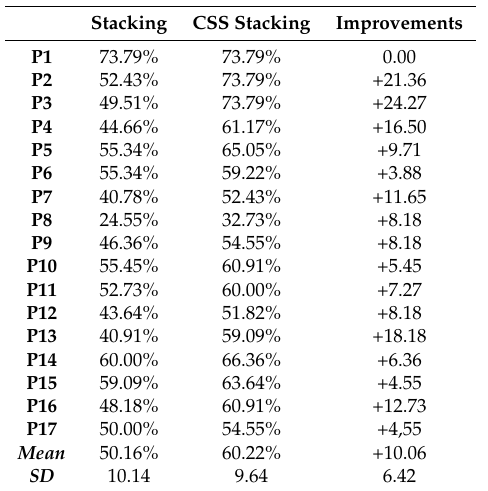
Table 6. First phase. Accuracies and improvements per person in percentage points comparing stacking and CSS stacking with EDA classification methods using SVM as the meta classifier. Mean and SD rows denote the average and standard deviation for each classification method and improvements considering all of the